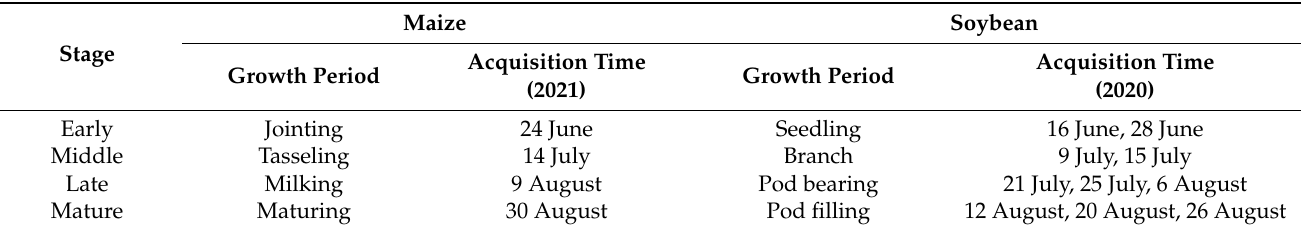
Table 2. Dates of spectral reflectance